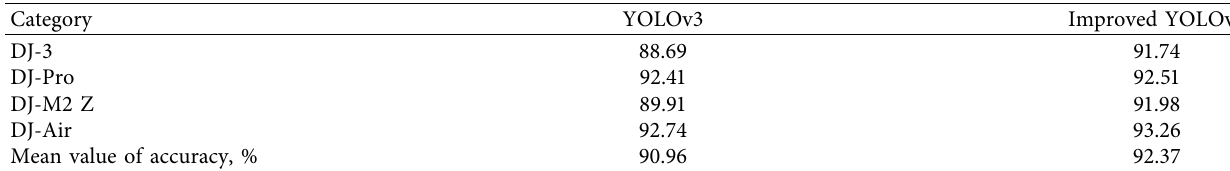
Table 4: Classification accuracy of two algorithms on